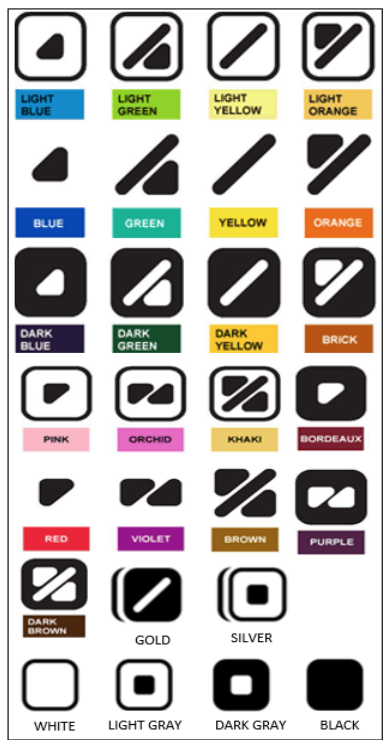
Figure 8. ColorADD color identification system. Source: http://www.coloradd.net/code.asp